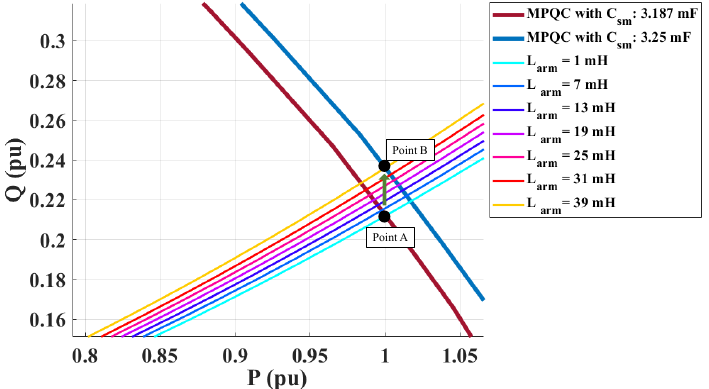
Figure 6. Changes in PQ loading curves of MMC with different arm inductance values.